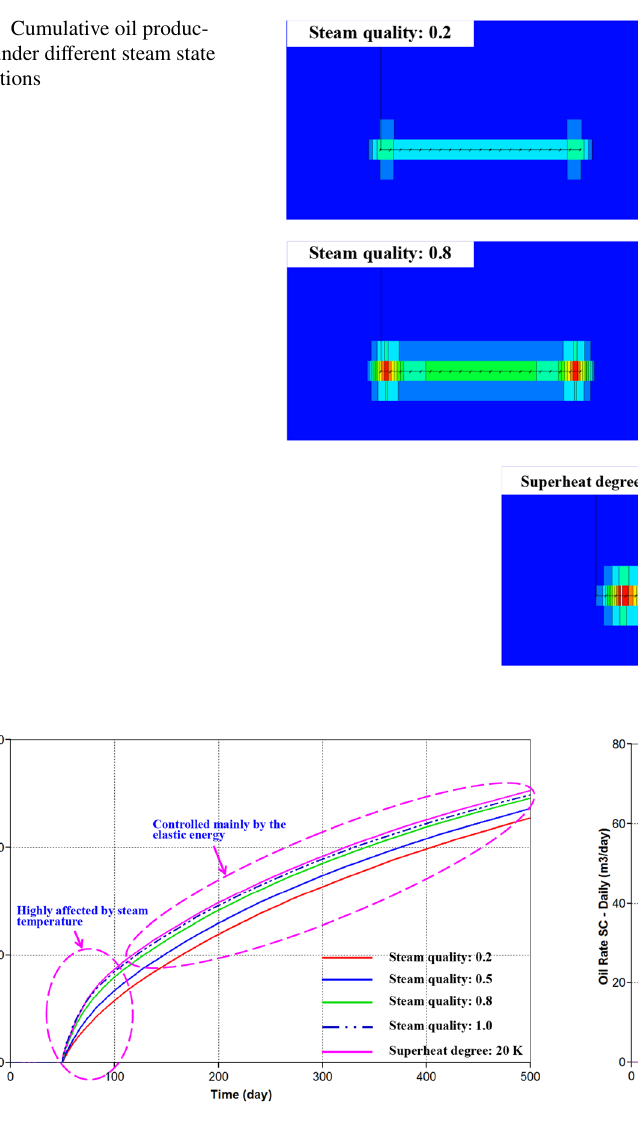
Fig. 8 Comparison of the oil production rate under saturated or superheated steam injection (Xu et al. 2013)